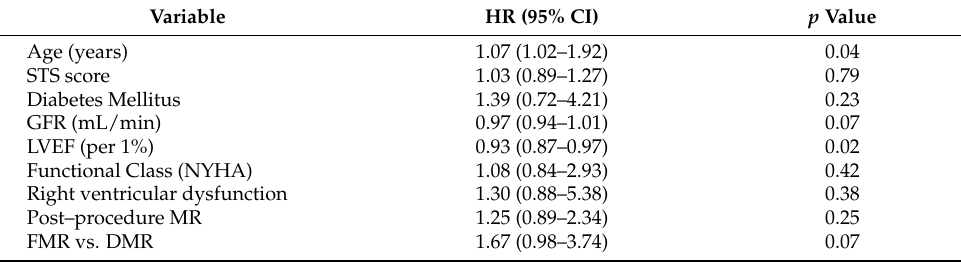
Table 5. Cox regression for